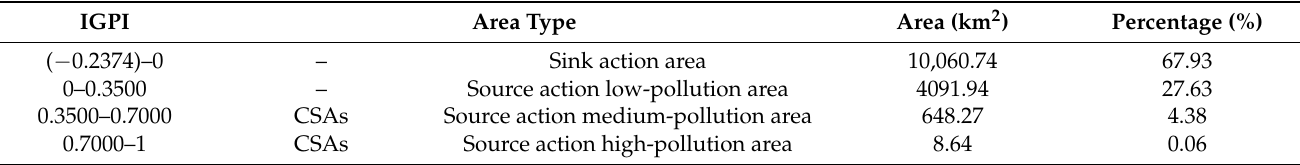
Table 2. The area and percentage of NPS pollution CSAs in the Jiulong River watershed.